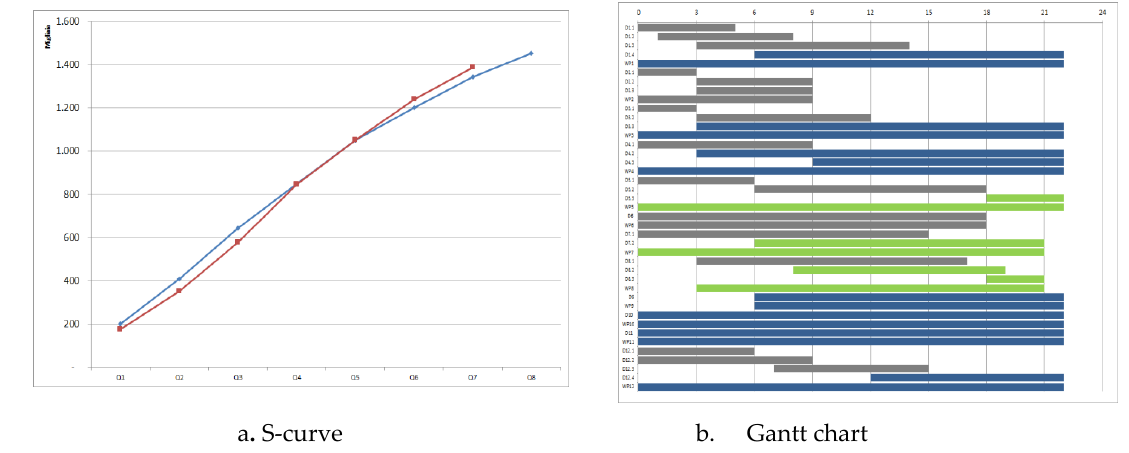
Figure 9 . Secure Platform .